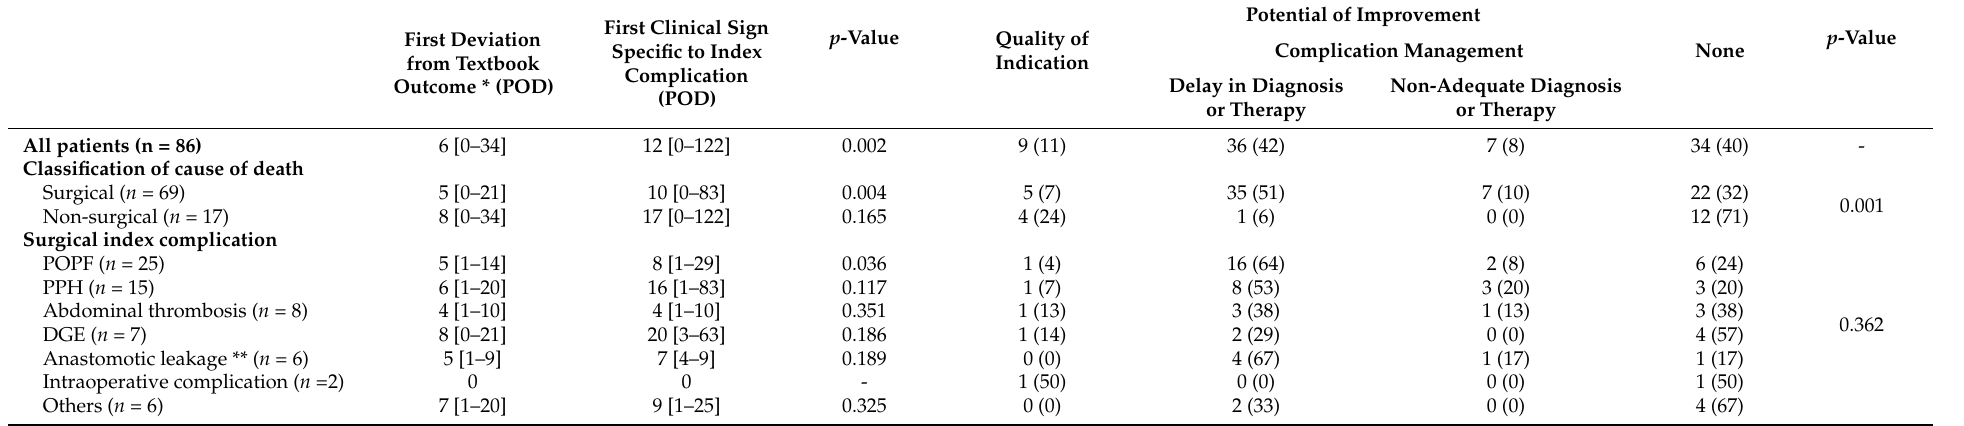
Table 3. Time to first deviation from textbook outcome and reviewer ratings regarding potential of improvement.